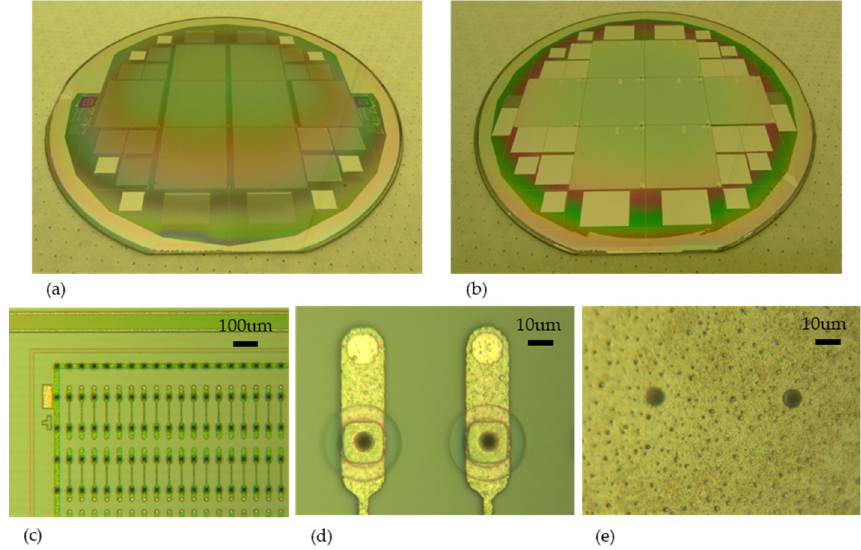
Figure 12. Front side ( a ) and backside ( b ) photographs of IBL wafers. View of FE-I4 devices, front side ( c , d ) and backside ( e ) from ATLAS Forward Proton(AFP) production.